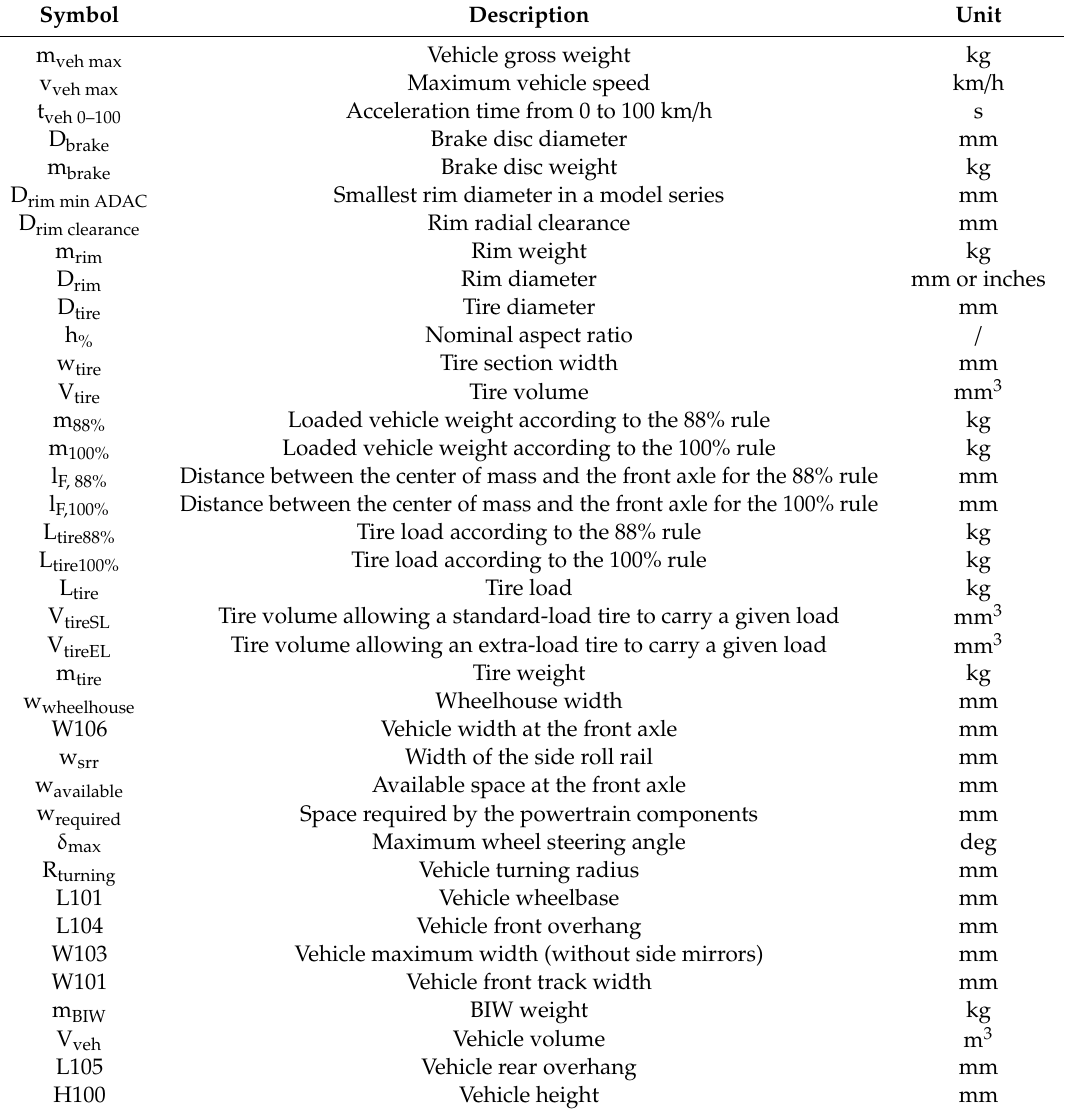
Table A4. List of employed